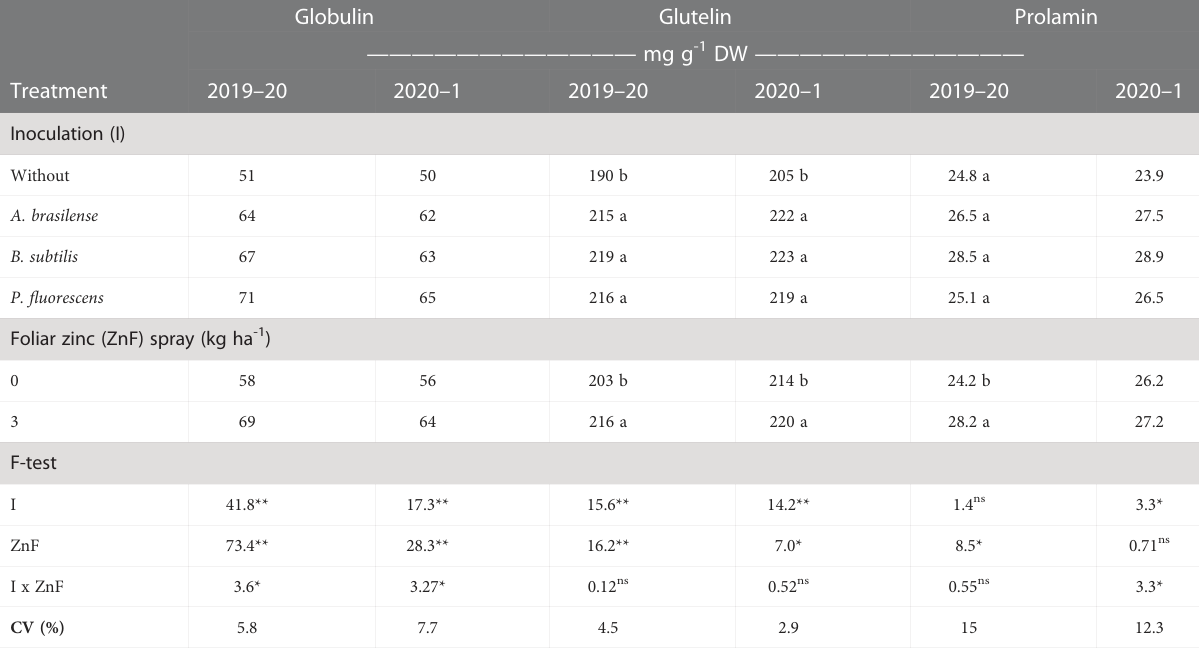
TABLE 7 Globulin, glutelin and prolamin concentration of maize grains as a function of plant growth-promoting bacteria inoculation, together with or without nano-zinc oxide spray, in the 2019 – 20 and 2020 – 1 cropping seasons. Globulin Glutelin